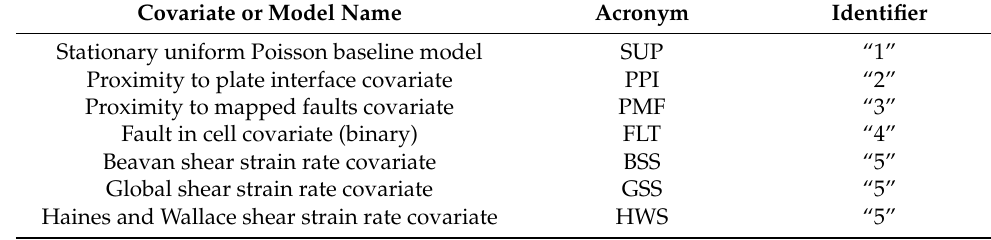
Table 1. Name, acronym, and identifier for the baseline model and covariates.